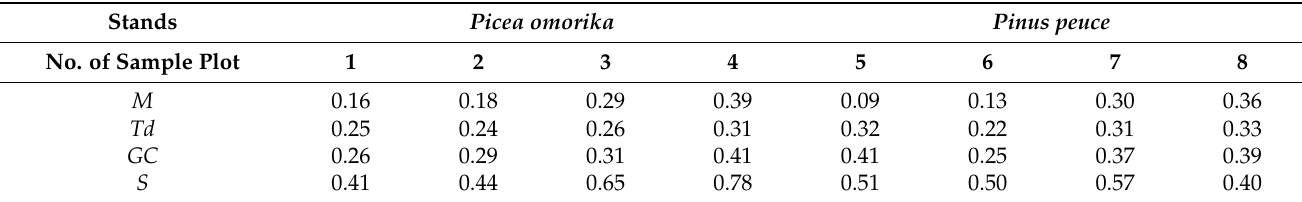
Table 5. Parameters of diameter diversity in the investigated stands.